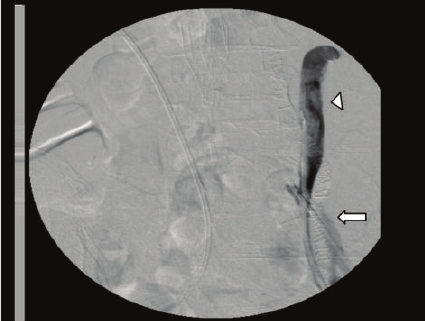
Figure 1: Contrast injection in left ureteral stump (arrowhead) showing extravasation in left common iliac artery (arrow).